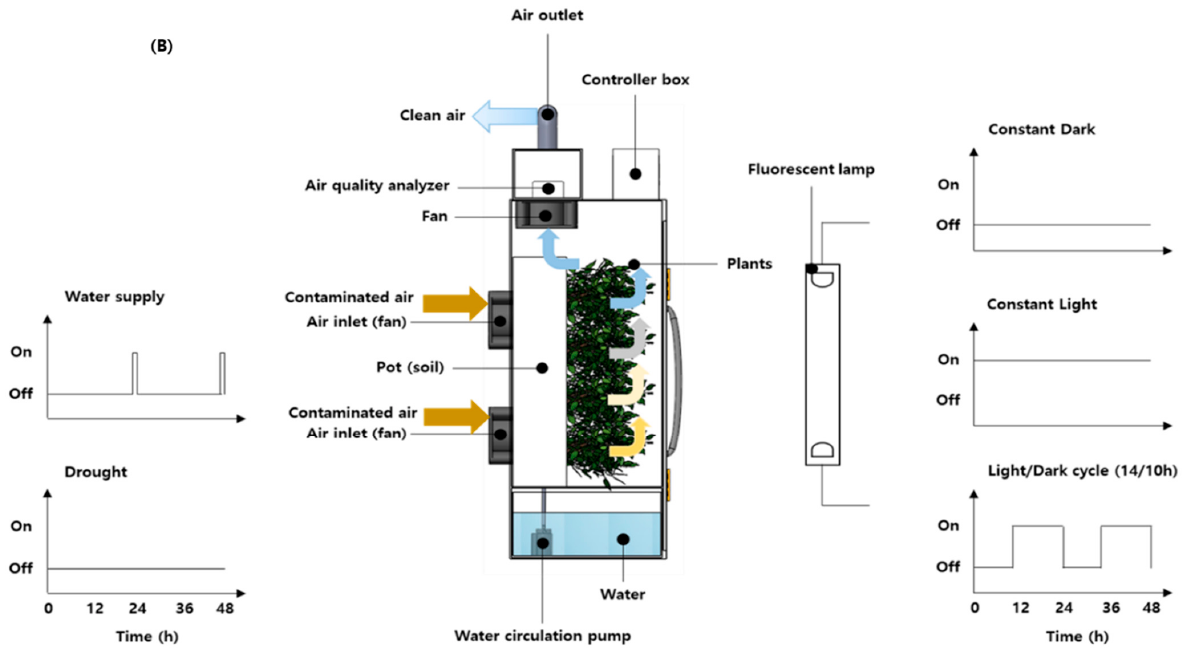
Figure 1. Schematic of ( A ) plant-based biofilter system and ( B ) different operating conditions (illumination and watering).